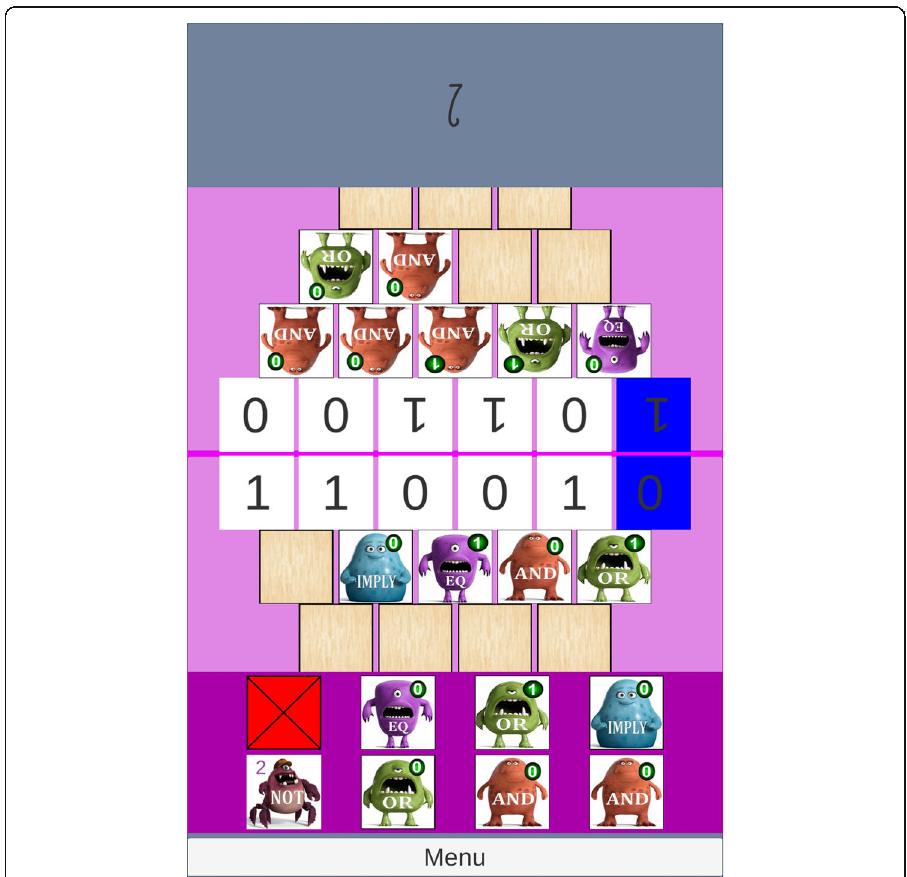
Fig. 6 Version 4 - two-players mode using one